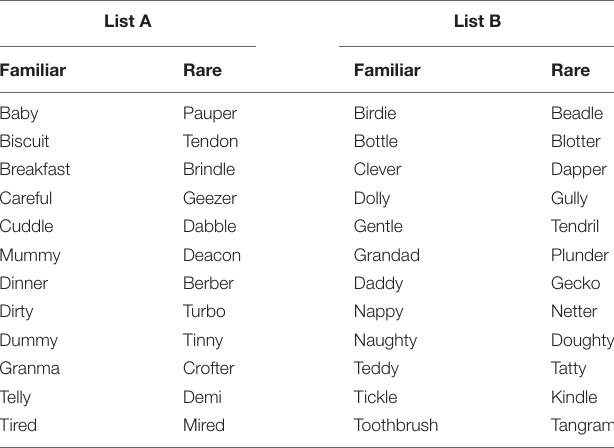
TABLE 1 | Word stimuli for the AHPP